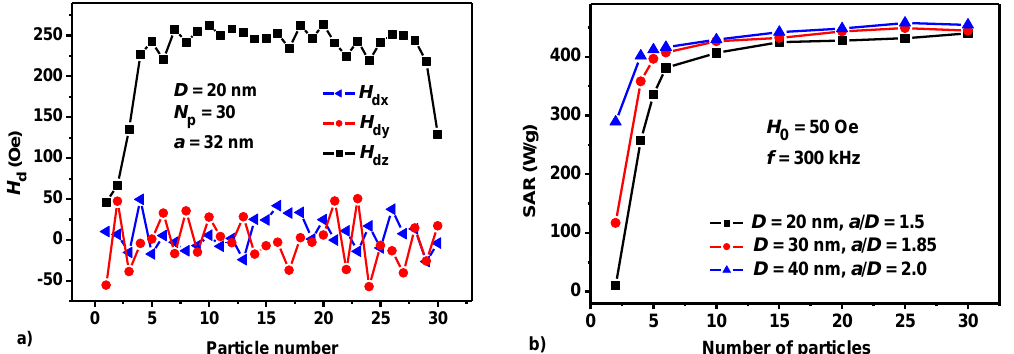
Figure 3. ( a ) Distribution of the components of the interaction field depending on the position of the nanoparticle in the chain. ( b ) Dependence of the SAR of a dilute chain assembly on the number of particles N p in the chainswith particles of different diameters, D = 20–40 nm, assuming the optimal ratios a / D for various chains.